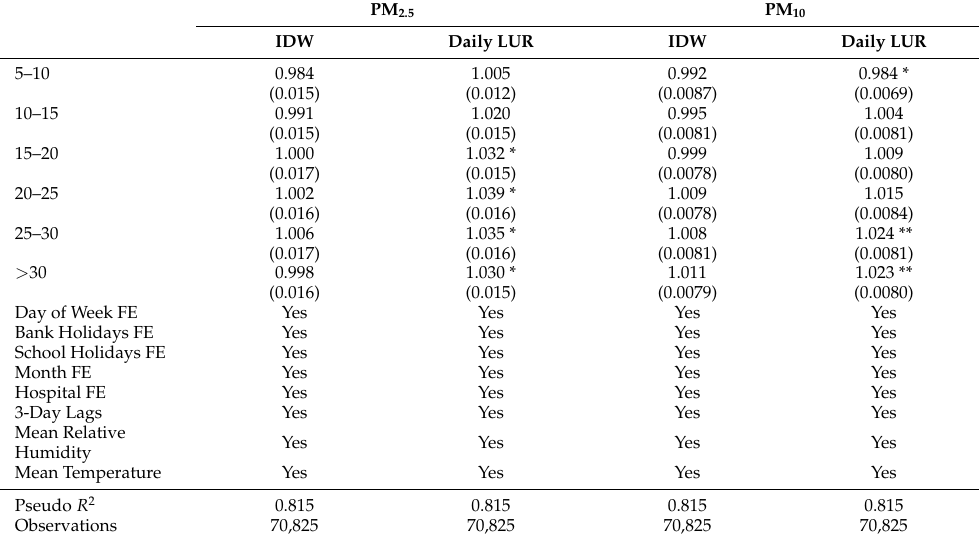
Table A5. Incidence risk ratios (IRR) of the effect of exposure on a day in a given range of PM, relative to a day in the 0–5 µgm − 3 range. This represents the contemporaneous effect of PM ( β p ). A value of 1 represents no change. Estimates are shown for PM 2.5 & PM 10 . Estimates are shown for two pollution exposure assignment methods: inverse distance weighting (IDW) and daily land use regression (daily